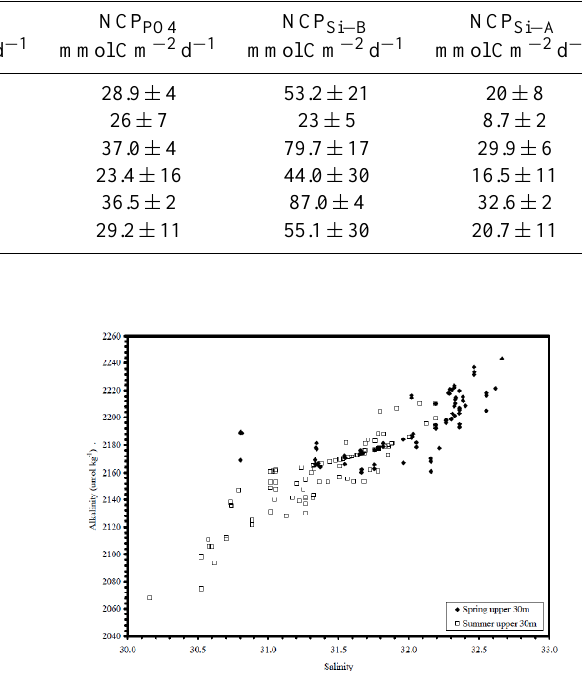
Fig. 10. Spring and summer concentrations of TA (µmoleskg − 1 ) in the upper 30m of the water column. Overall, TA concentrations were lower in summer than in spring, although some summer values were higher. This seasonal change necessitates the application of a correction factor to NCP estimates which accounts for the formation and dissolution of TA.